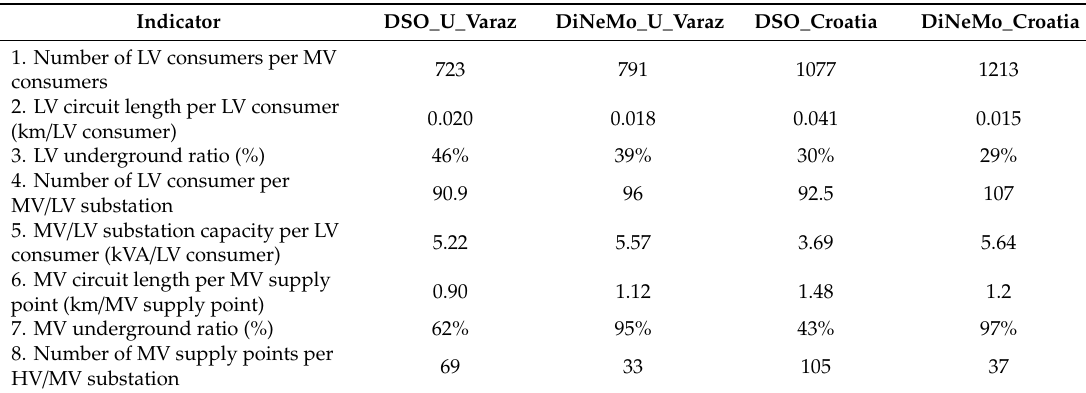
Table 3. Comparison of indicators for city center.